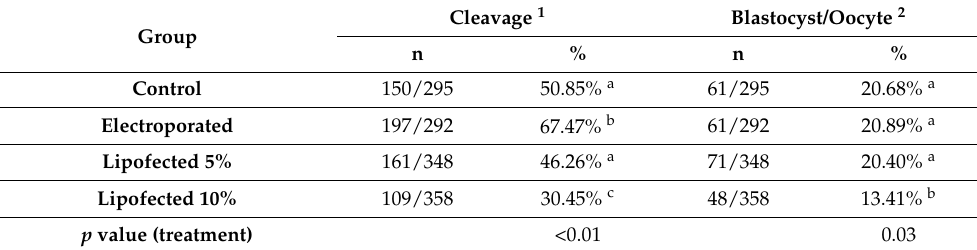
Table 3. Embryo development parameters (cleavage and blastocyst formation rates) after electropora- tion or lipofection with the CRISPR/Cas9 system. Variables were analyzed via the non-parametrical Kruskal–Wallis test. When significant differences were detected ( p < 0.05), the values were compared via the Conover–Iman test for pairwise comparisons.